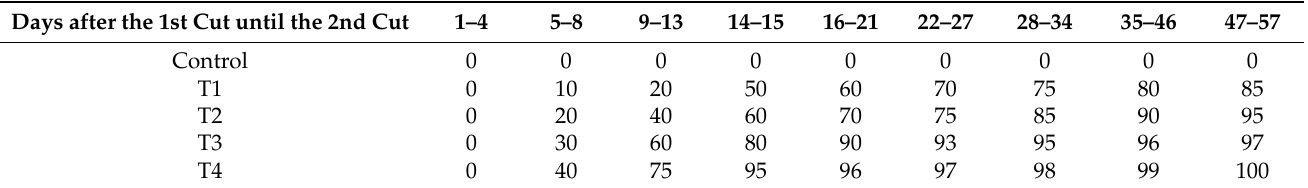
Table 2. Details of the treatment for the period of the second cut season; level of depletion ( p ) as % of total available water—TAW-(C.I. Tibaitat á ,